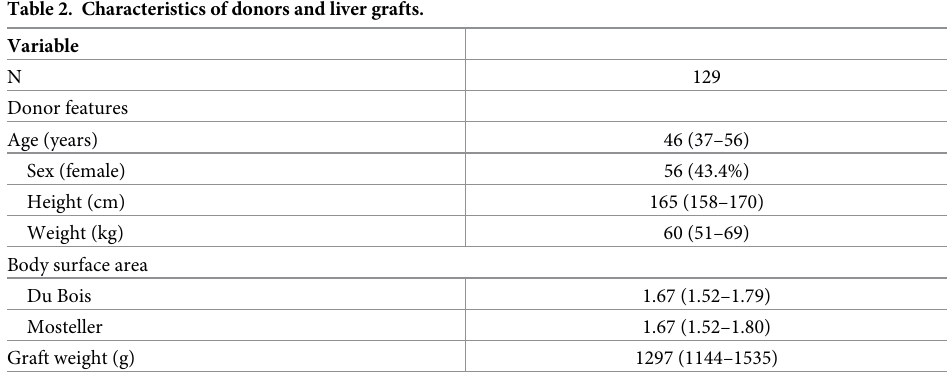
Table 2. Characteristics of donors and liver grafts.